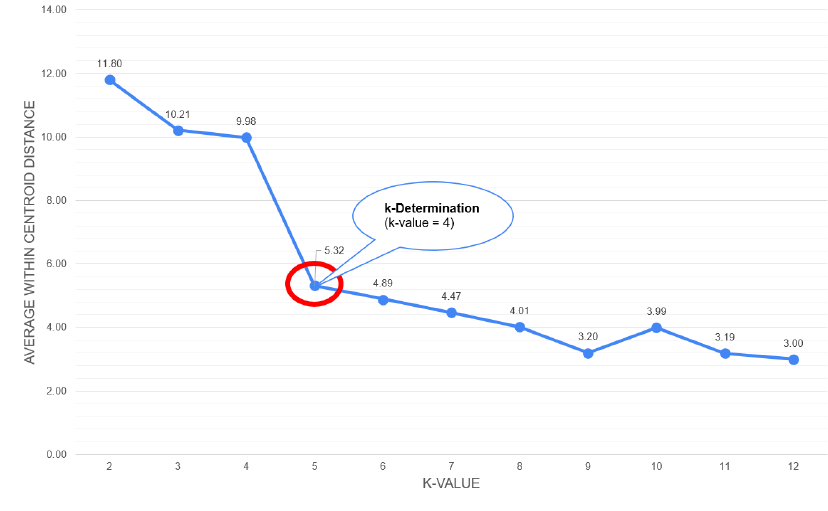
Fig. 3. 𝑘 -Determination using the Elbow